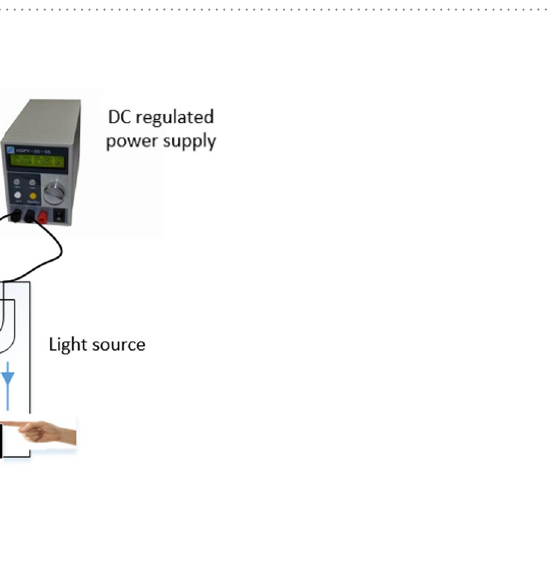
Figure 3. Schematic of the calibration set selection in non-grouping modeling. Note: n represents the number of all samples.